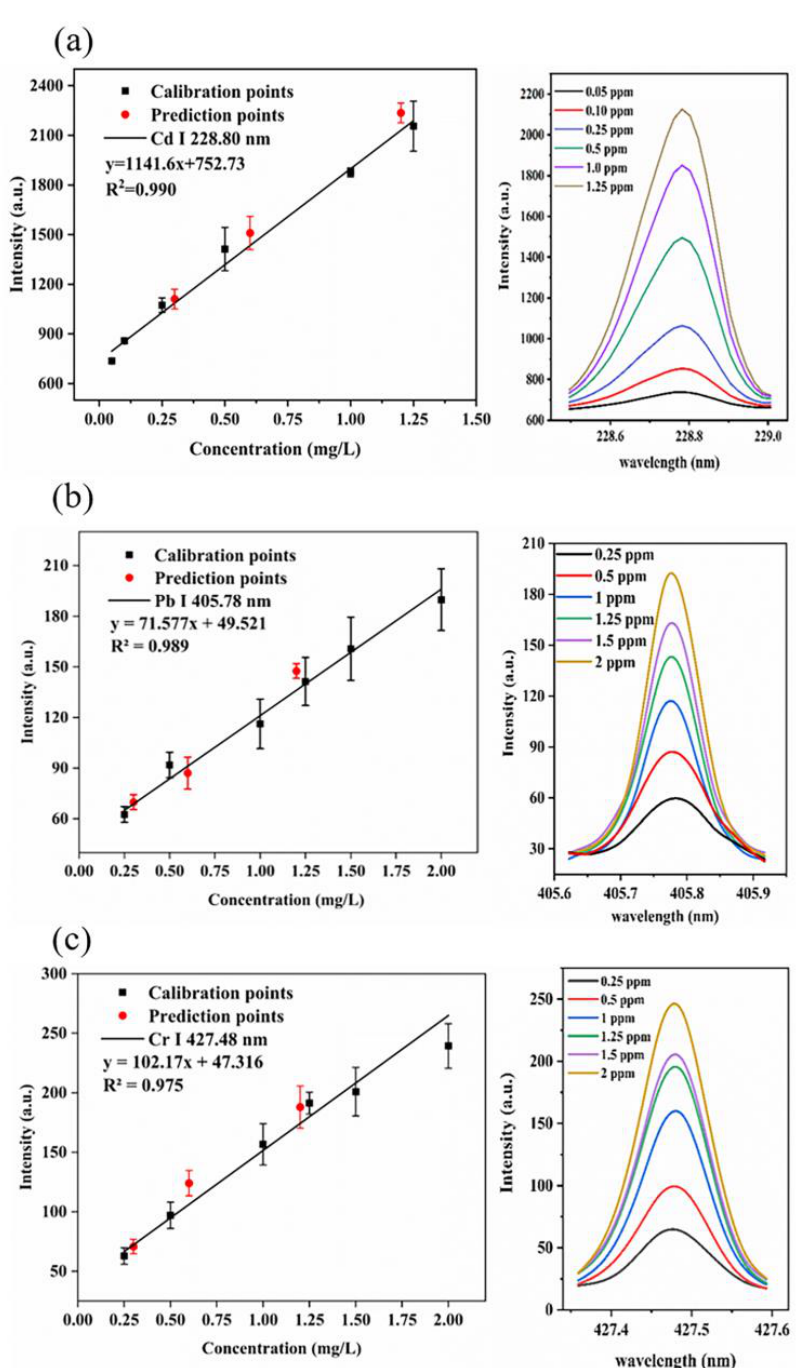
Figure 5. ( a ) Calibration curve of Cd (I) 228.80 nm. ( b ) Calibration curve of Pb (I) 405.78 nm. ( c ) Calibration curve of Cr (I) 427.48 nm. The error bars are the standard deviations of four replications. The right pictures are the spectral intensity of samples with different elemental concentrations in solution.